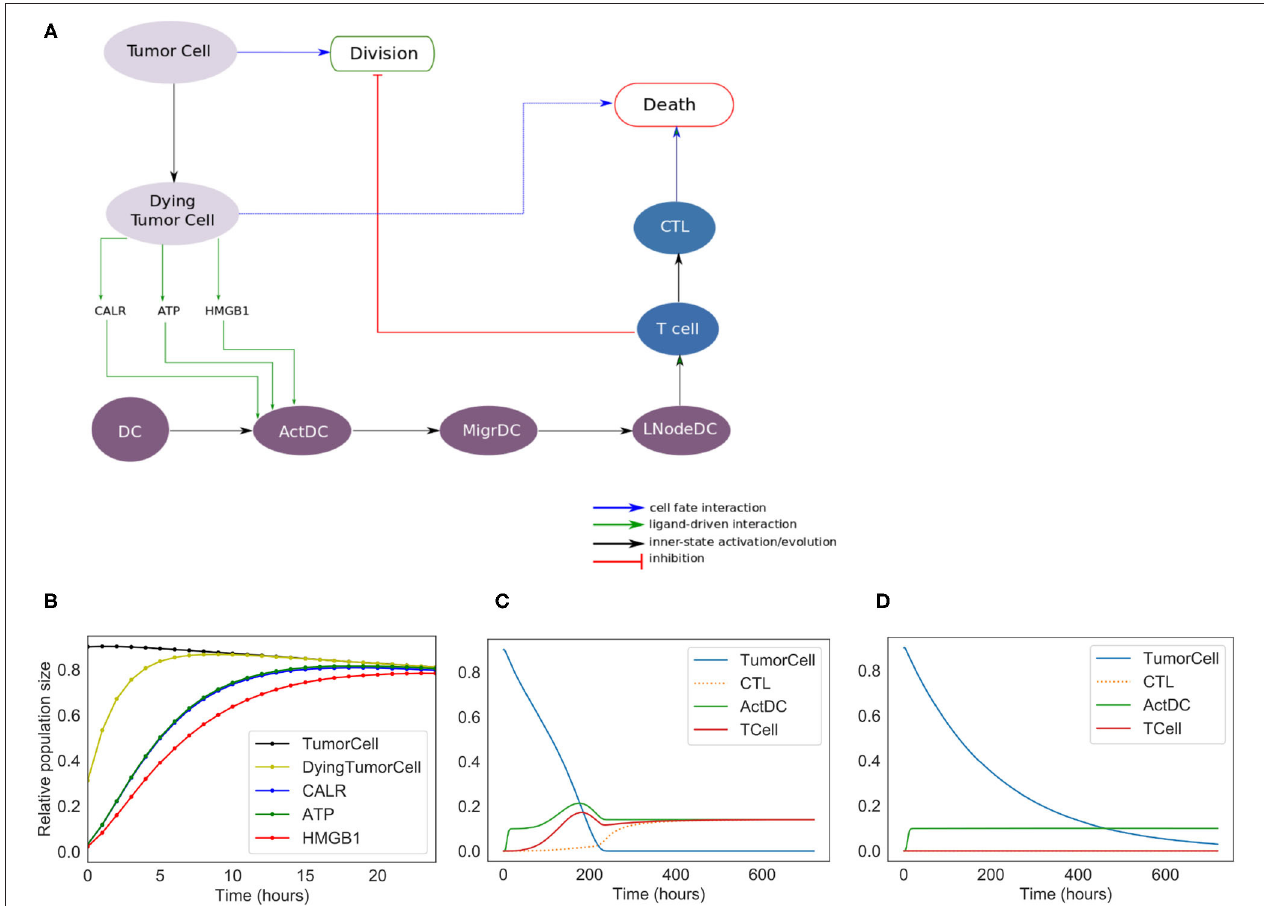
FIGURE 2 | Phenomenological model. (A) Influence network of the simplified version of ICD: it involves three cell types: tumor cells (Tumor Cell and Dying Tumor Cell for cells that have been treated by chemotherapeutic agents, gray nodes), dendritic cells (DC for immature dendritic cells, ActDC for mature dendritic cells, MigrDC for migrating dendritic cells, and LNodeDC for dendritic cells in the lymph node, purple nodes), T cells (T Cell, and CTL for cytotoxic T lymphocyte, blue nodes). (B) Early activation of ICD markers (Note: CALR overlaps with ATP). (C) Kinetics of the cell types with ICD. (D) Kinetics of the tumor cell populations without ICD.